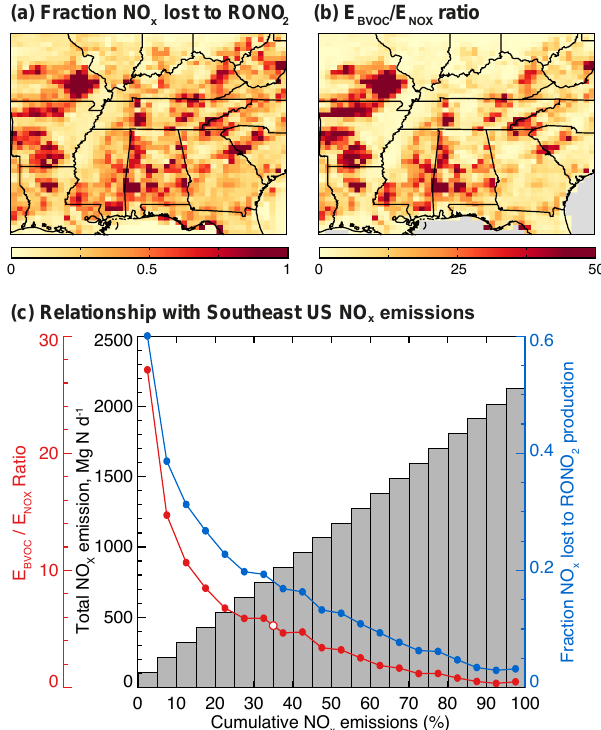
Figure 12. Importance of organic nitrates as a sink for NO x , as a function of BVOC and NO x emissions. (a) Simulated fraction of emitted NO x that is lost to RONO 2 production in Southeast US surface air. (b) Ratio of BVOC (isoprene + monoterpene) emis- sions ( E BVOC ) to NO x emissions ( E NO ). (c) Mean values of vari- x ables from (a) and (b) as a function of cumulative NO x emissions in the Southeast US. Model grid squares have been sorted by NO x emissions, then grouped into bins that each represent 5% of total Southeast US NO x emissions. Values shown for the fractional NO x sink due to RONO 2 production (blue) and the mean E BVOC /E NO x emissions ratio (red) represent the mean within each bin. NO x emis- sions are shown as cumulative totals (gray) in MgNday − 1 . The Southeast US mean E BVOC /E NO emissions ratio (5.3) is high- x lighted with a white